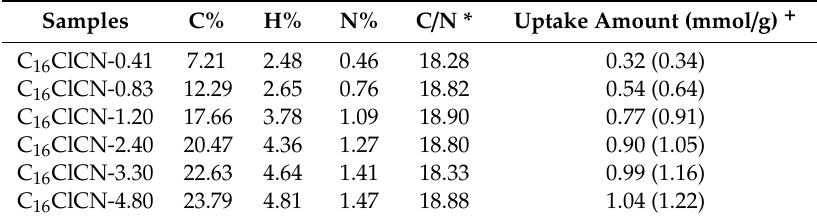
Table 2. C, H, N elemental analysis of di ff erent C 16 Cl-CN prepared from C 16 Cl solutions with di ff erent initial